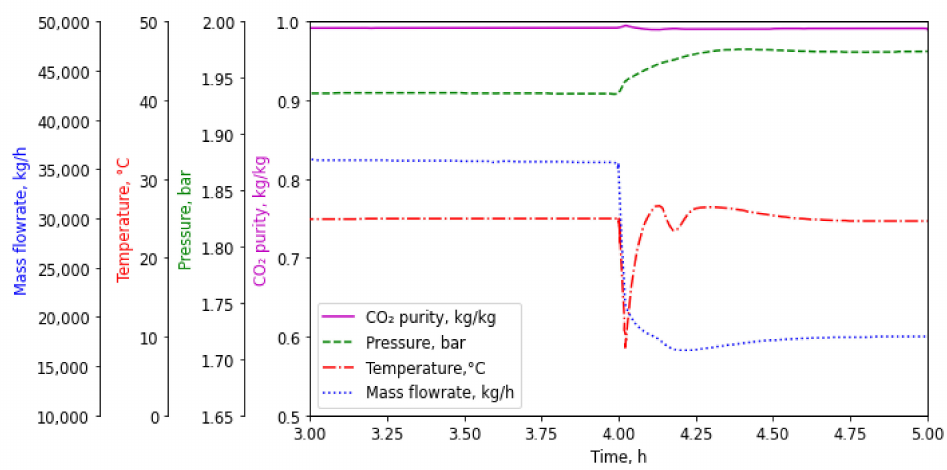
Figure 5. Disturbance rejection in the desorber unit for change in flue gas flow